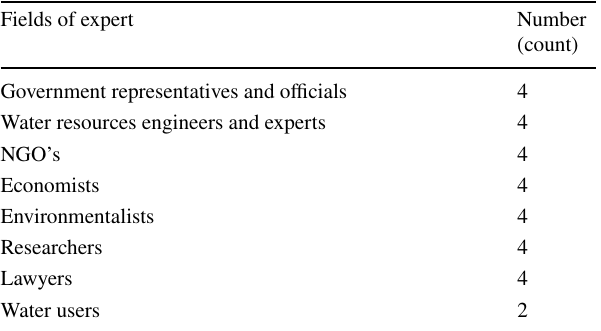
Table 2 Details of the consulted experts Fields of